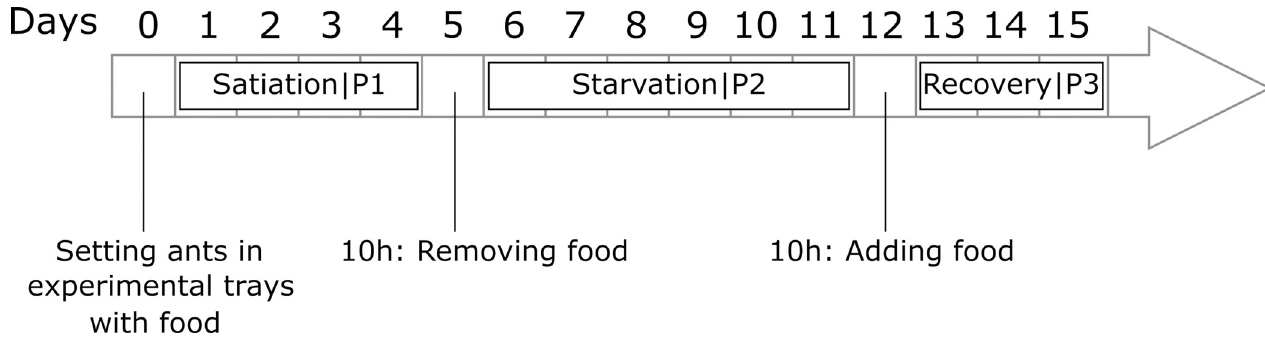
Fig 2. Timeline of the experiments with three different phases. Satiation phase = P1, Starvation phase = P2 and Recovery phase = P3.